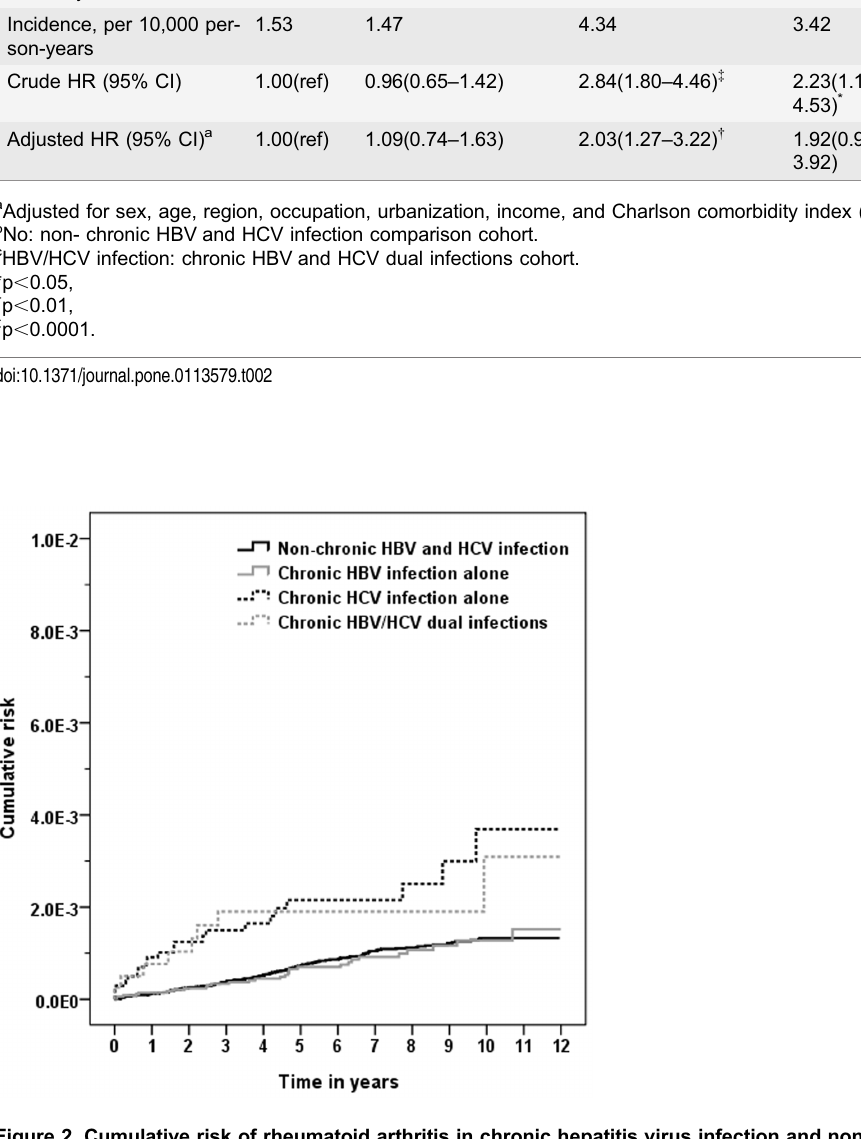
Figure 2. Cumulative risk of rheumatoid arthritis in chronic hepatitis virus infection and non-chronic HBV and HCV infection comparison cohorts over the 11-year follow up period. Log-rank test: